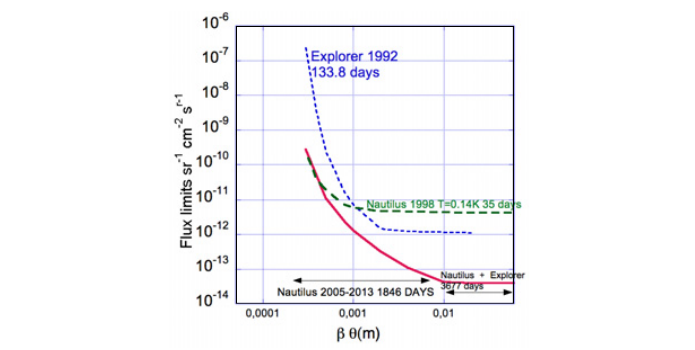
Figure 3. 90% C.L. isotropic flux upper limits compared to previous results (Explorer) [6]. The bottom curve, in red, shows the results of this analysis. The EXPLORER data are used in combination to the NAUTILUS data only for (cid:5)(cid:4) ( M ) > 0.01. Limits from a short run with NAUTILUS at T = 0.14 K, in green, may be interesting because of the different detection mechanism in the superconducting state. The limits are computed using the so called optimum interval method [13], for finding an upper limit of a one-dimensionally distributed signal in the presence of an unknown background. The signal is assumed to have the distribution computed by Montecarlo using Eqs. (2) and (3).